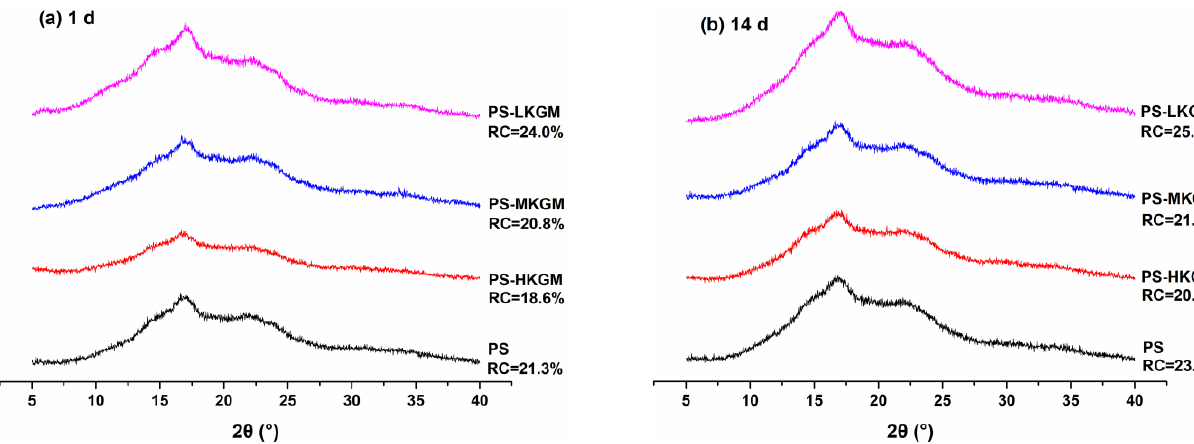
Figure 5. XRD spectra and relative crystallinity of PS-KGM mixtures stored for one day ( a ) and 14 days ( b ). (HKGM, MKGM and LKGM represent KGM with high, medium and low molecular weight, respectively. PS represent pea starch. RC represents relative crystallinity).